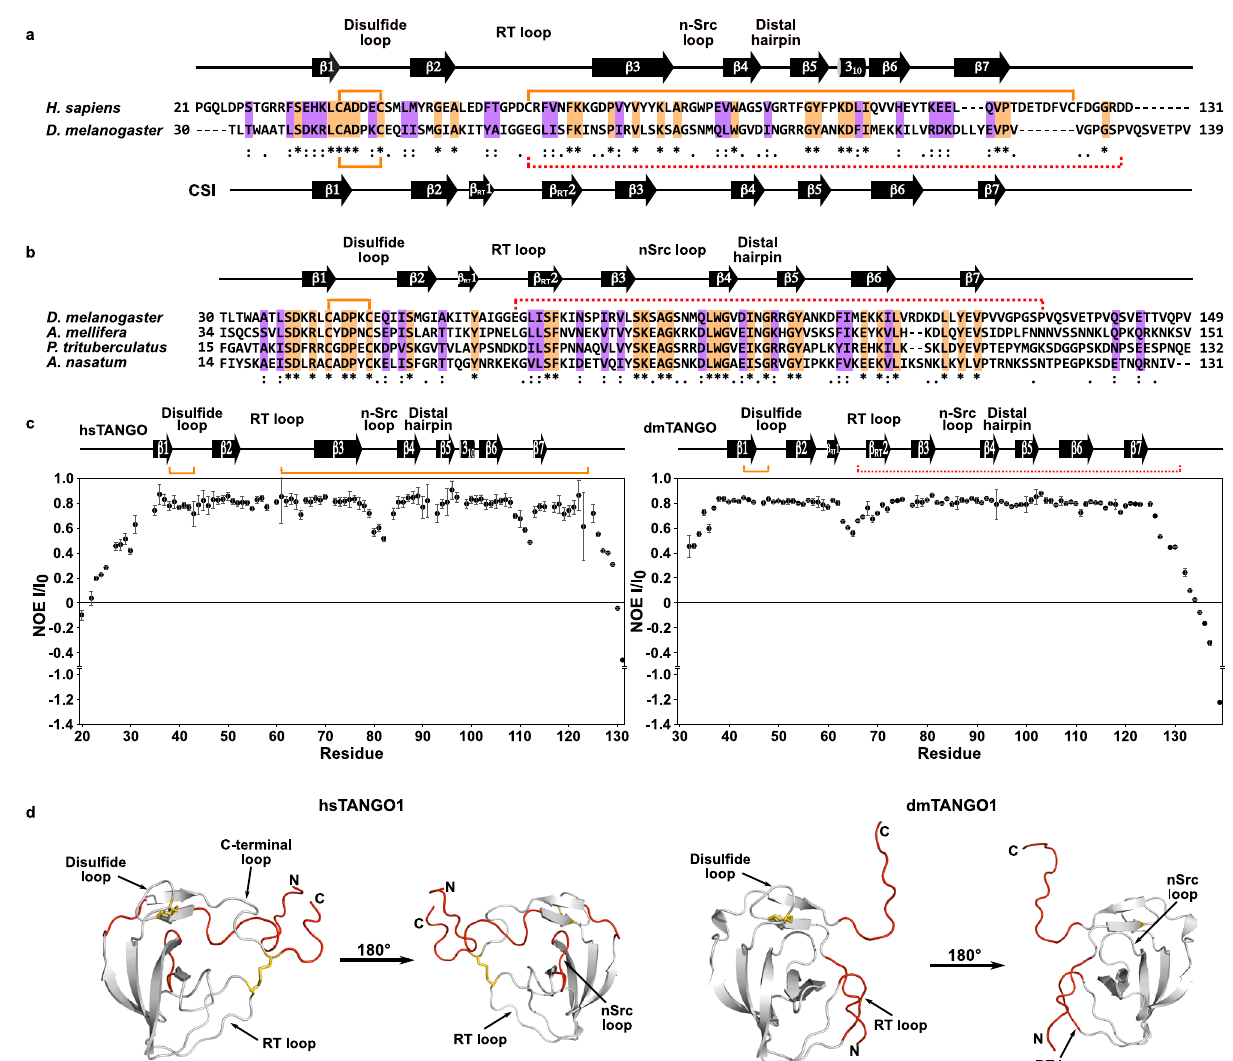
Fig. 2 | The cargo-recognition domain is conserved in invertebrates and dis- tinctlydifferentfromthevertebratedomain.a SequencealignmentofTANGO1 ’ s cargo-recognition domain from Homo sapiens and Drosophila melanogaster com- puted with ClustalOmega. Conserved and semi-conserved residues are displayed by asterisks and colons also highlighted in orange and purple, respectively. Dis- ul fi de bridges are indicated by orange lines, secondary structure elements above andbelow,accordingtothedeterminedstructureorthechemicalshiftindex(CSI). Themissingseconddisul fi debridgeininvertebratesisindicatedbydottedredline (See also Supplementary Fig. 3). b Multiple sequence alignment of several